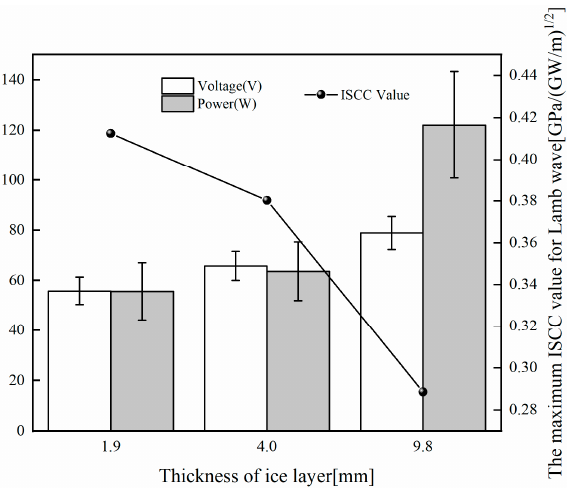
Figure 18. De-icing voltage, power, and the maximum ISCC value for ice layers with varying